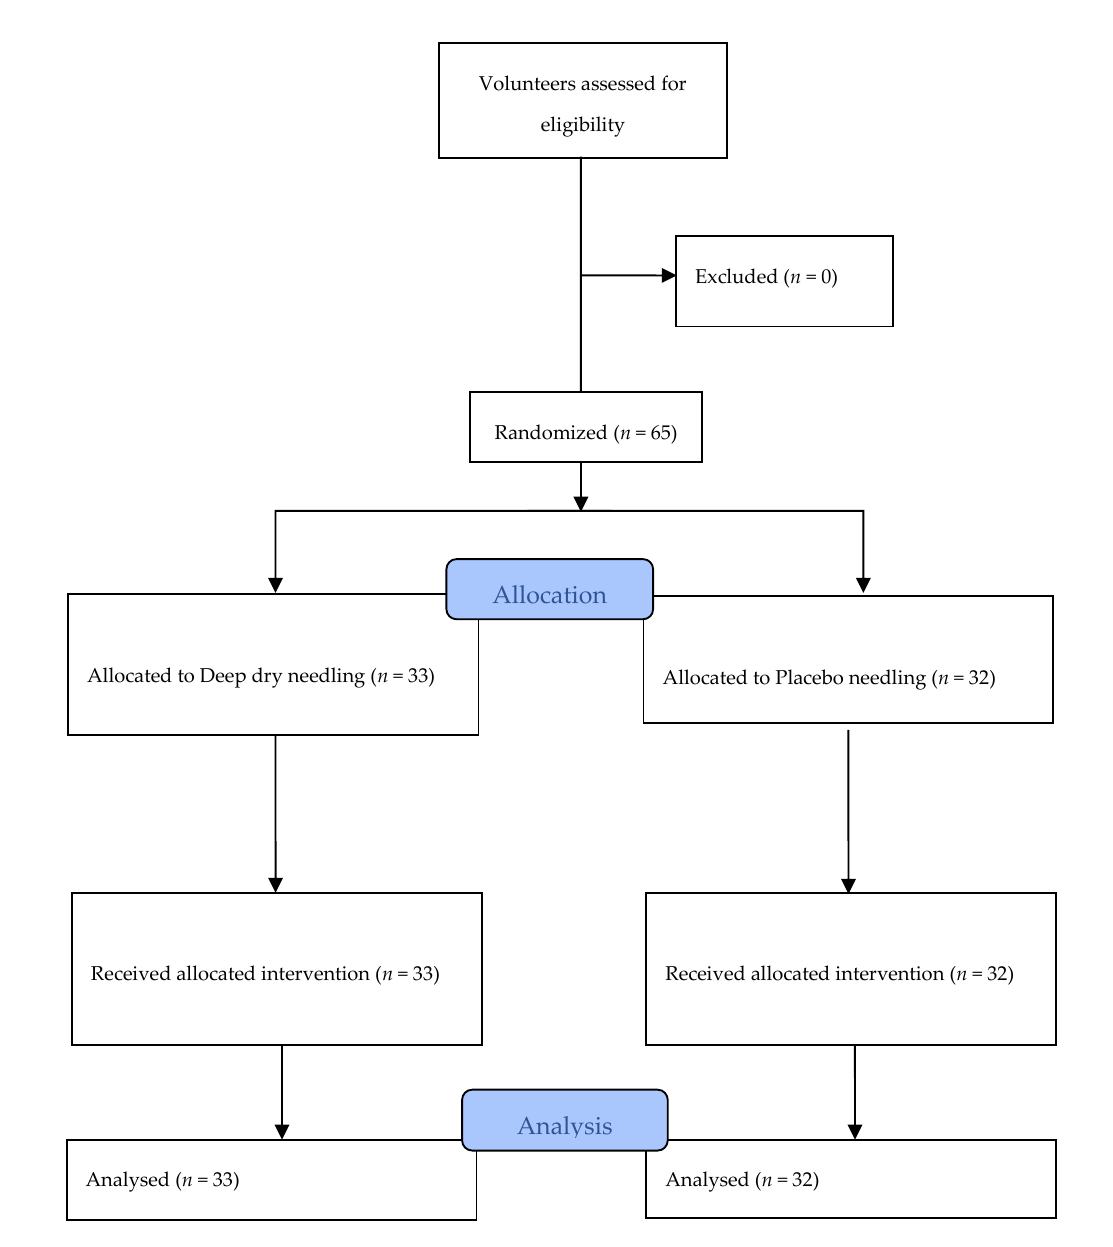
Figure 4. Flow diagram of patients throughout the course of the study. Table 2. Primary and secondary Table 1. Demographic characteristics of each treatment group.